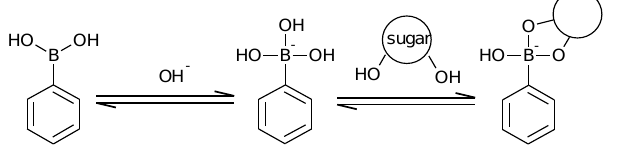
Figure 1. Equilibriums of phenylboronic acid and sugar.